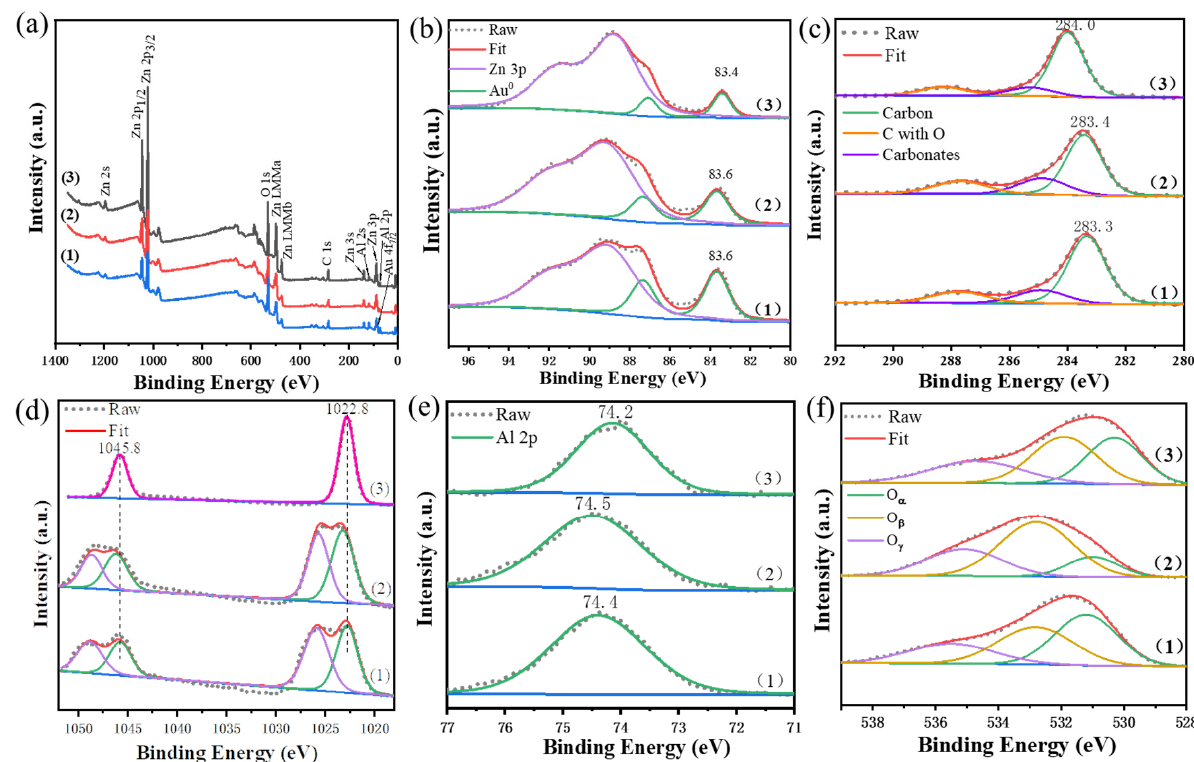
Figure 5. ( a ) XPS wide spectra and ( b ) Au 4f, ( c ) C 1s, ( d ) Zn 2p, ( e ) Al 2p ( f ) O 1s of XPS spectra over the Au 25 /Zn x Al-400 catalyst: (1) Zn 2+ /Al 3+ = 1; (2) Zn 2+ /Al 3+ = 2; (3) Zn 2+ /Al 3+ = 3.